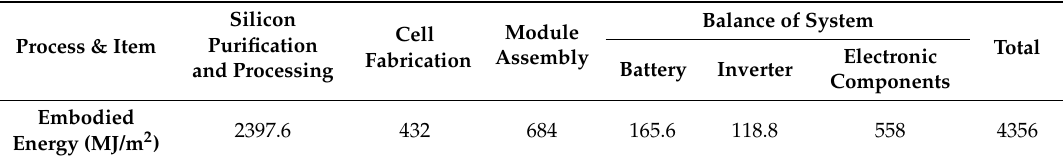
Table 6. Embodied energy of the single-crystal solar PV system [39].